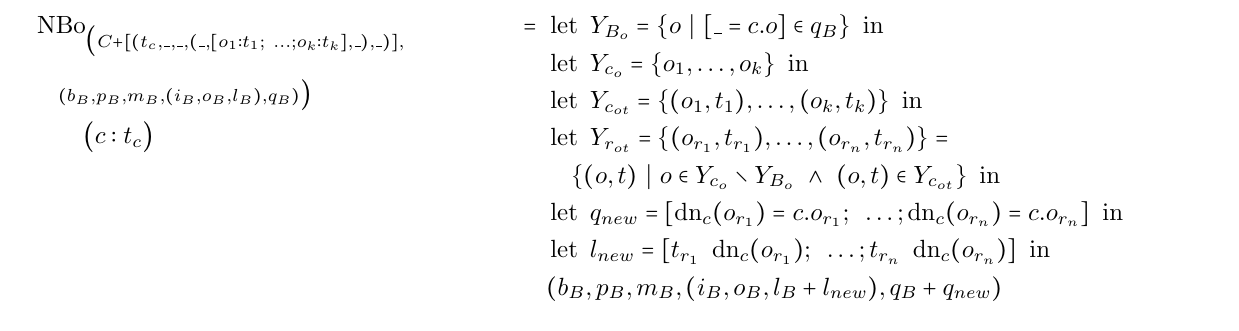
Figure 22: Function NBo—Add “dummy” equations for component outputs that are not accessed in the instan- tiating block. Normalization requires that all outputs of a component have bindings to equations in the block that instantiates the component.